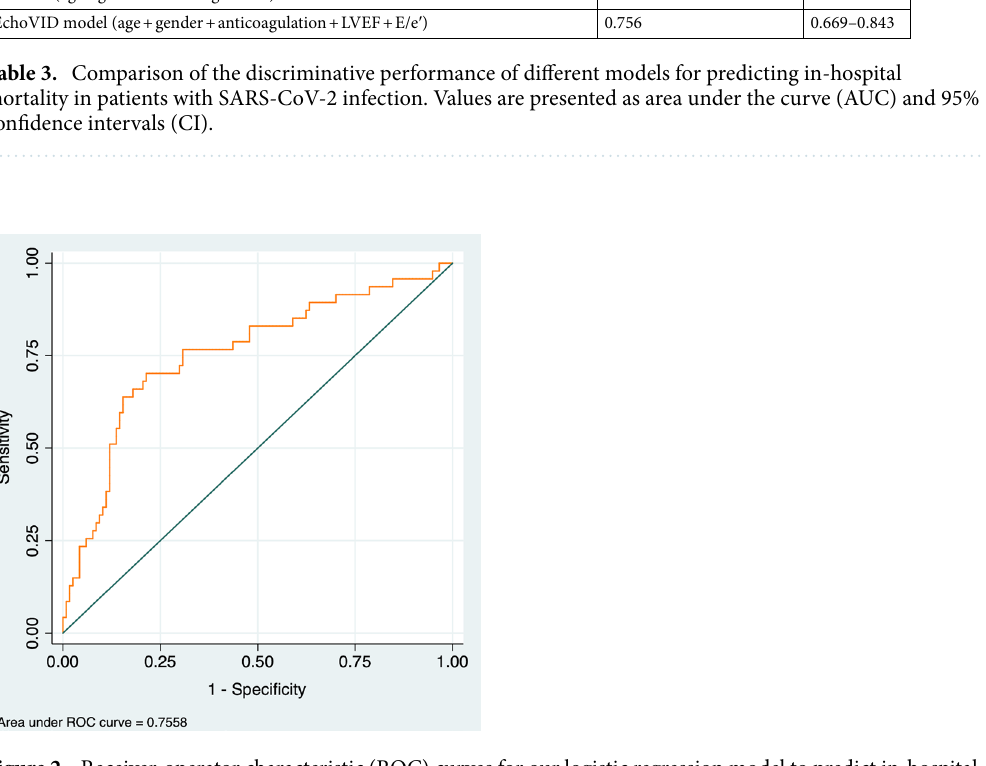
Figure 2. Receiver-operator characteristic (ROC) curves for our logistic regression model to predict in-hospital mortality. The model included the following variables: age, gender, left ventricular ejection fraction, E/e ′ ratio and anticoagulation